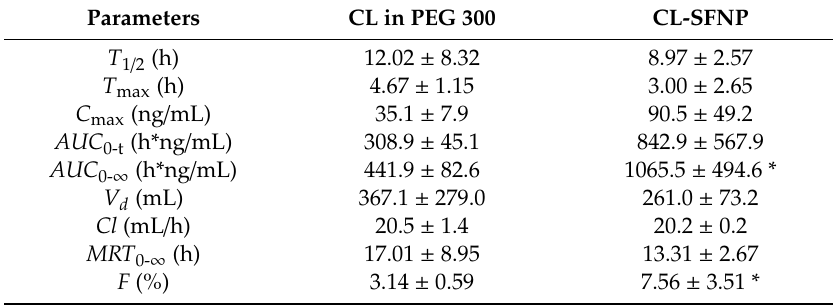
Table 6. Pharmacokinetics parameters of CL after oral administration of pure CL and CL-SFNP at 3 mg / kg ( n =